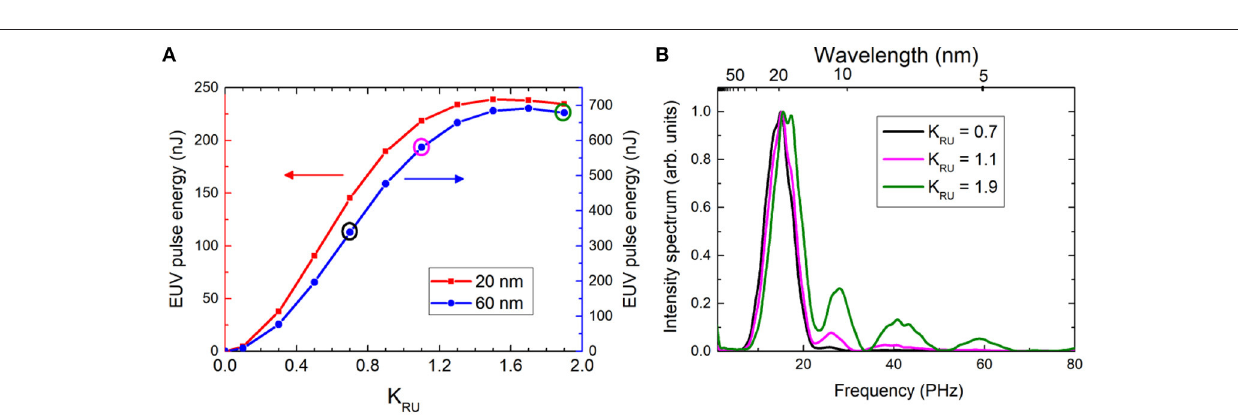
FIGURE 5 | (A) Dependence of the attosecond EUV pulse energy on RU undulator parameter at 20nm (red) and 60nm (blue) wavelengths. (B) EUV pulse spectra for three different K RU